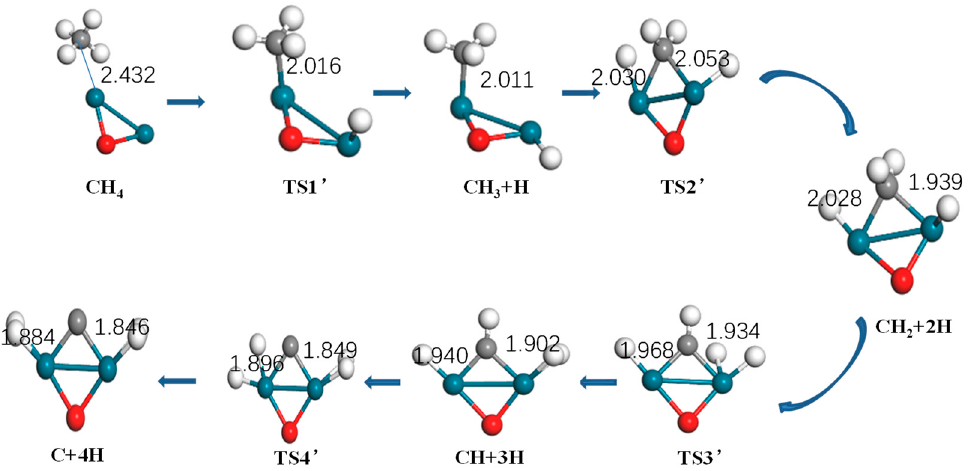
Figure 5. Optimized structure of reactants, intermediates, products, and the transition state of methane activation by Pd 2 O (turquoise: Pd, gray: C, white: H).